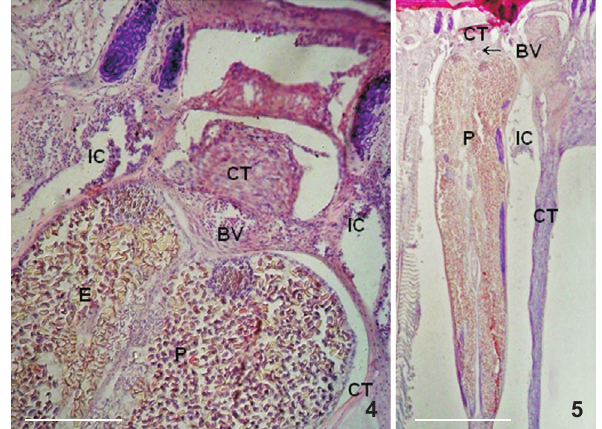
Figures 4-5. Histological sections of Didymocylindrus simplex in gill arch and lamellae of Katsuwonus pelamis . Scale bars: 4 = 200 µm, 5 = 500 µm. (BV) Blood vessel, (CT) connective tissue, (E)